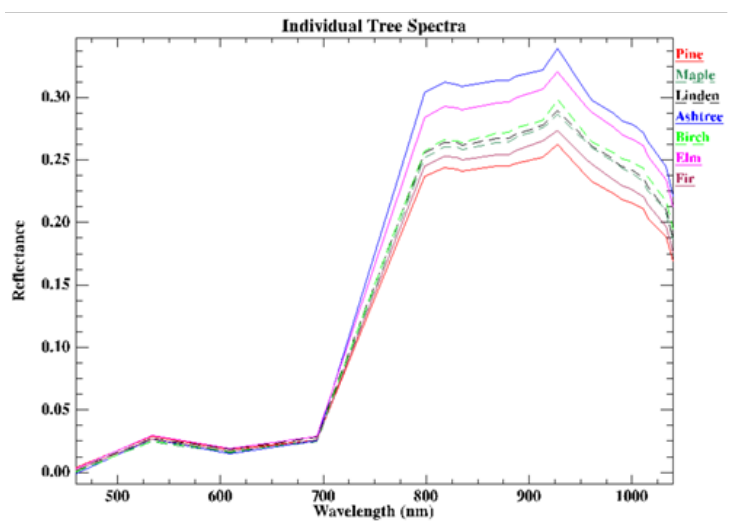
Figure 7. Count of the tallied trees with a height greater than 15 m.